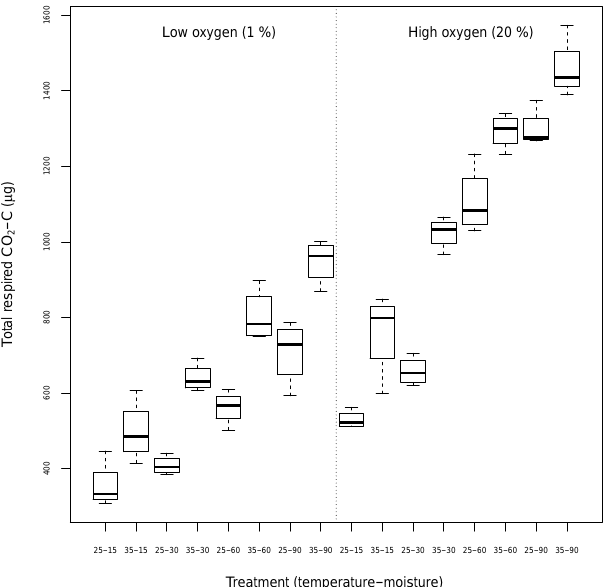
Figure 1. Total respired CO 2 integrated over the length of the ex- periment by treatment. The umbers in the treatment level represent the level of temperature ( ◦ C) and soil water content